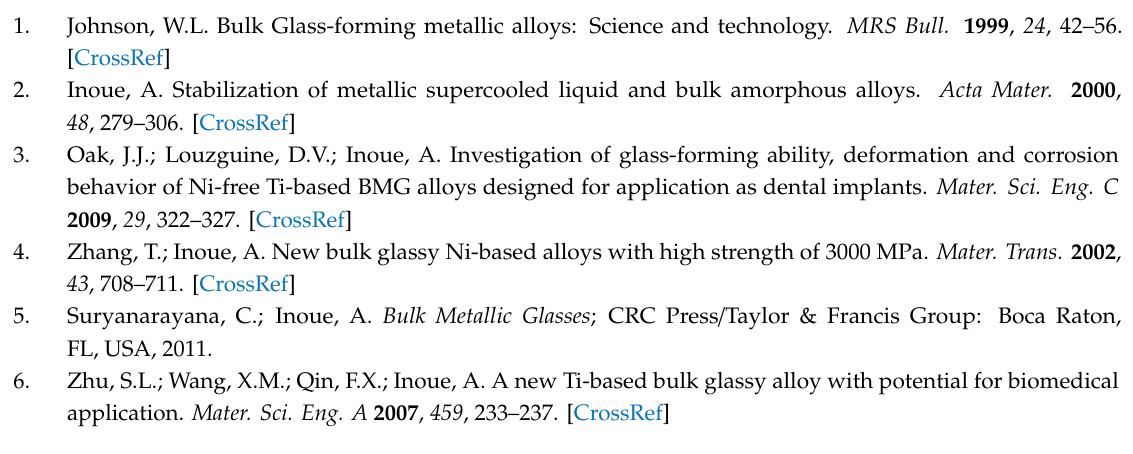
The potential is related to SCE (Ag /